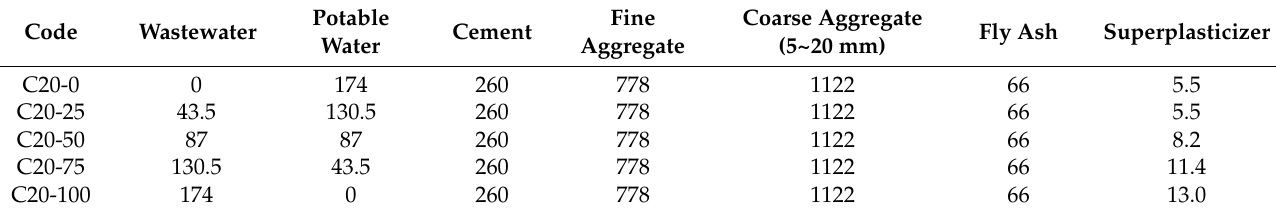
Table 4. Mix proportions of C20 concrete (kg/m 3 ).